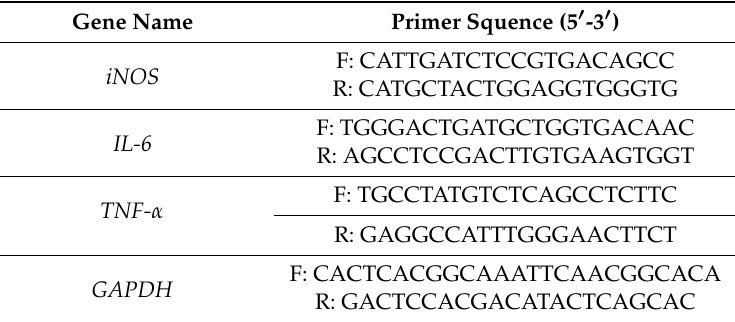
Table 1. The primer sequences for